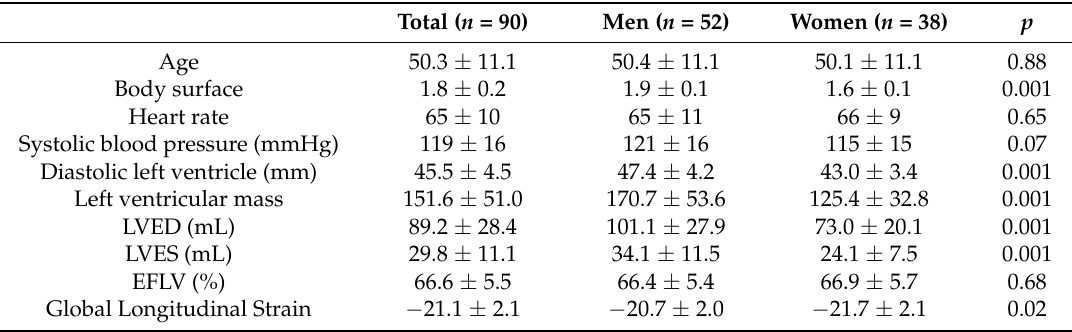
LVED: Left ventricular end-diastolic volume; LVES: Left ventricular systolic volume; EFLV: Ejection fraction of the left